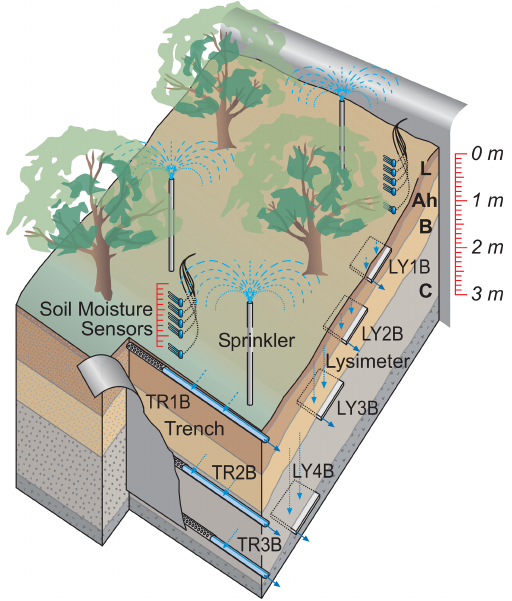
Figure 2. Experimental setup to measure vertical and lateral subsur- face flow with drainage pipes at three soil depths in a trench (TR1B, TR2B, TR3B) and zero-tension lysimeters (i.e., steel piling plates pushed in the undisturbed soil profile from the side of the hillslope; LY1B, LY2B, LY3B, LY4B). “B” indicates the sprinkling plot and is used to be consistent with other publications from the same